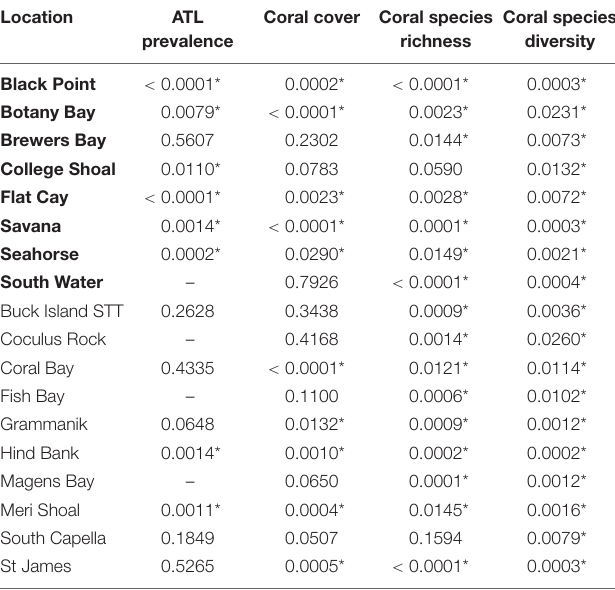
TABLE 3 | Overall results of Friedman’s rank non-parametric tests examining different reef metrics at long-term TCRMP locations through time. Location